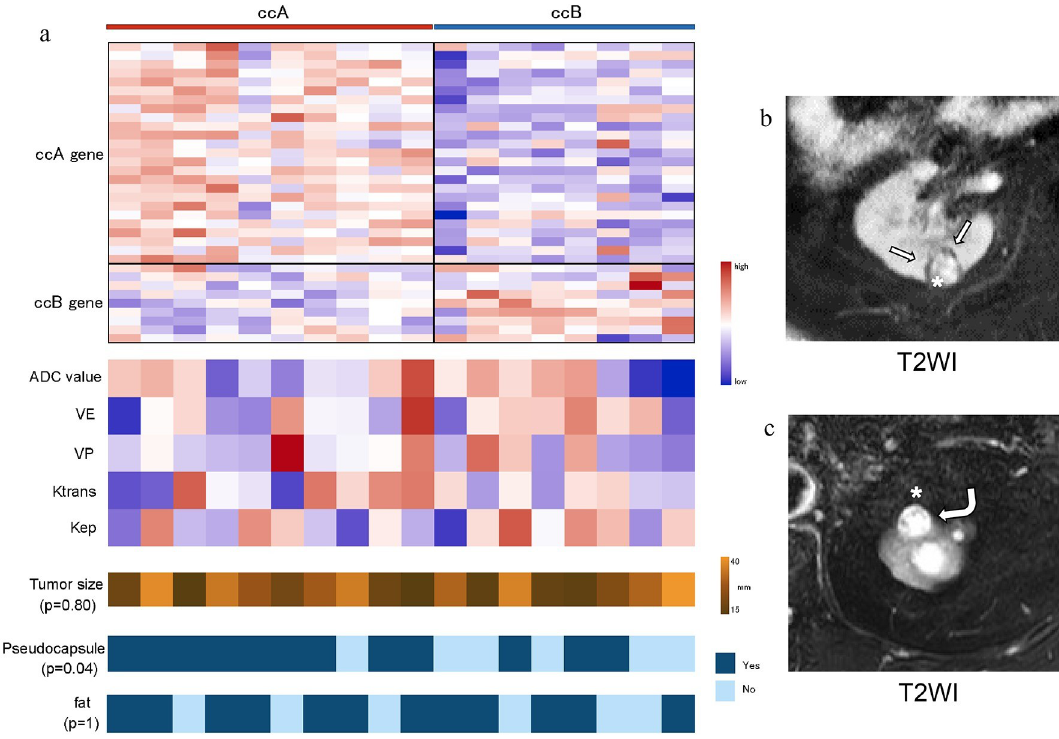
Fig 5. The relationships between the ccA/ccB subtype and the imaging parameters. a: The perfusion parameters, ADC, and tumor size were not correlated with the subtype. Only the presence/absence of a pseudocapsule (T2 rim) differed significantly between the subtypes (p = 0.04). b, c: Clear cell carcinomas ( asterisk ). b: MRI showed a hypointense rim surrounding the tumor in T2WI ( arrow ). This tumor was classified as the ccA subtype. c: MRI showed no hypointense rim in T2WI ( curved arrow ). This tumor was classified as the ccB